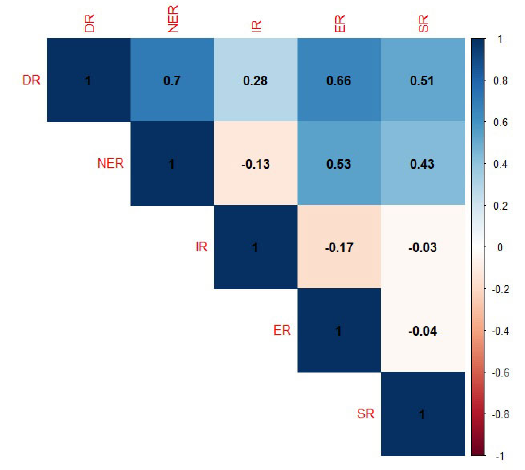
Fig. 8 . Correlation matrix for the disaster resilience and the four subsystems’ resilience. Note: SR = social resilience, ER = economic resilience, IR = infrastructure resilience, NER = natural environment resilience, DR = disaster resilience; the correlation matrix was calculated using Pearson’s correlation; r > 0 indicated a positive correlation between the two variables; r < 0 indicated a negative correlation of the two variables; |r| ≥ 0.8 indicated that the two variables were highly correlated; 0.5 ≤ |r| < 0.8 indicated that the two variables were moderately correlated; 0.3 ≤ |r| < 0.5 indicated that two variables had a low correlation; and |r| < 0.3 indicated that the correlation between the two variables was weak and basically